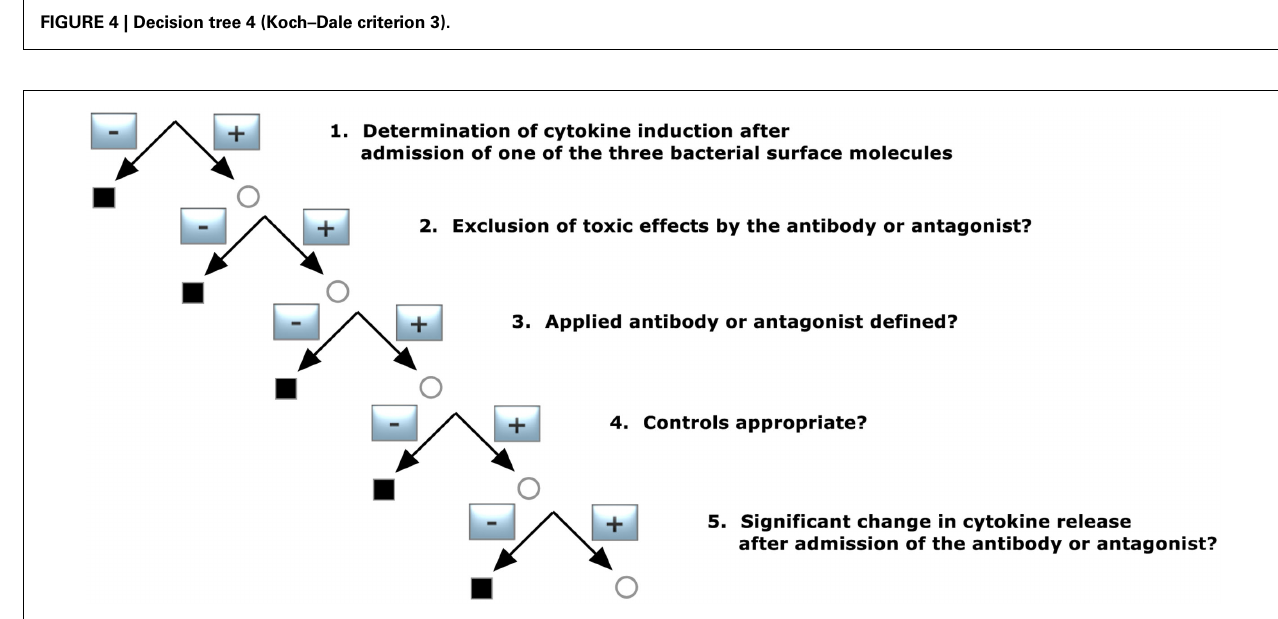
FIGURE 5 | Decision tree 5 (Koch–Dale criterion